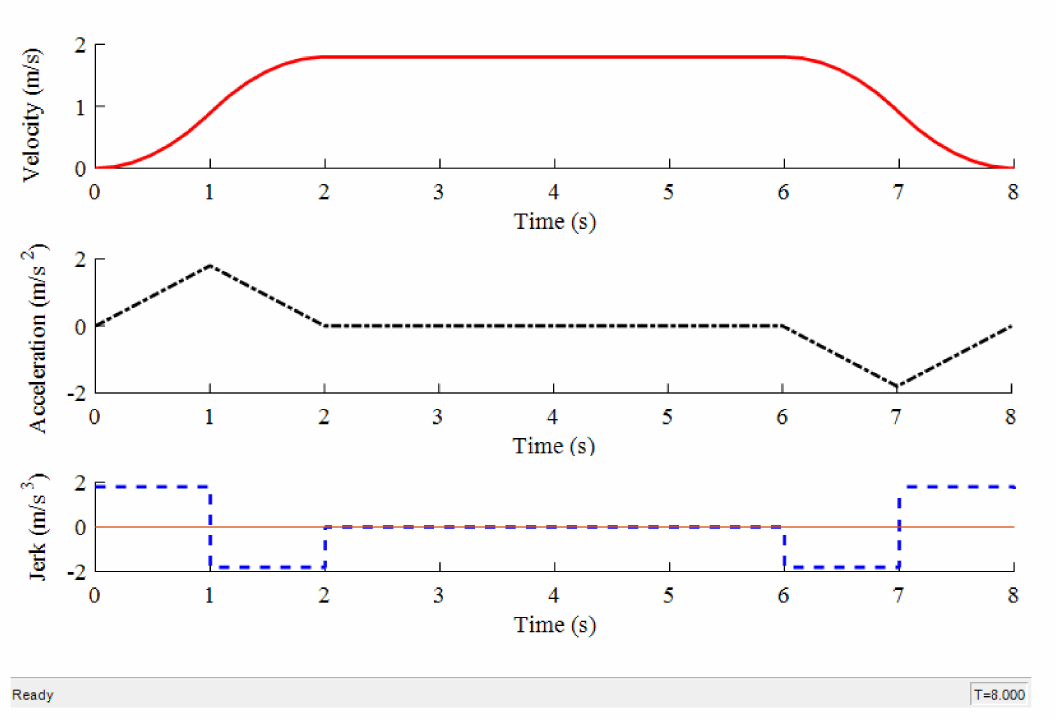
Figure 11. The motion state of